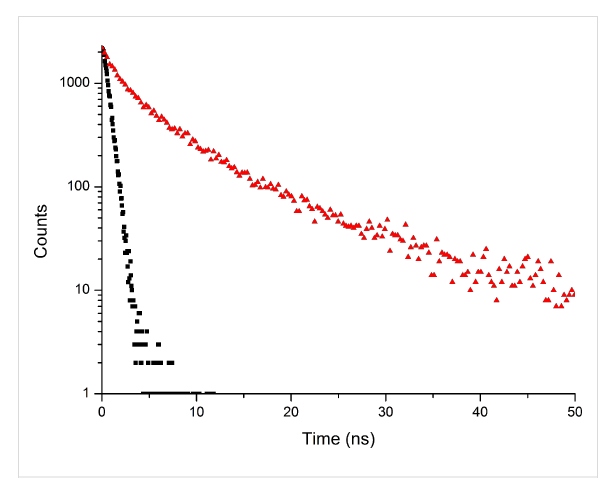
Figure 4: Luminescence decay in CH 2 Cl 2 solution (black) and as a thin film on quartz (red). In solution, a mono-exponential decay is observed with a lifetime τ ≈ 0.7 ns, while in the thin film, a multi-expo- nential decay is observed with an average lifetime τ ≈ 7.1